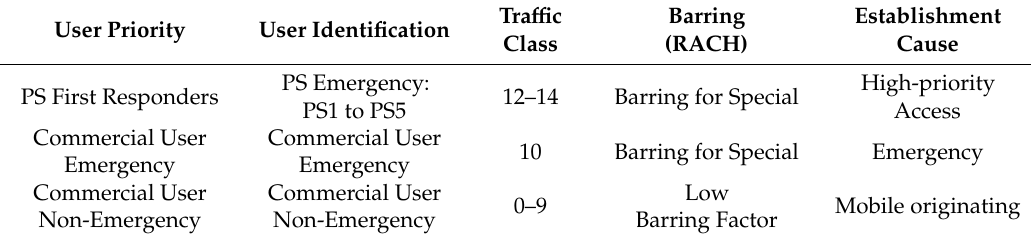
Table 1. User priorities in 3GPP ProSe LTE-A.